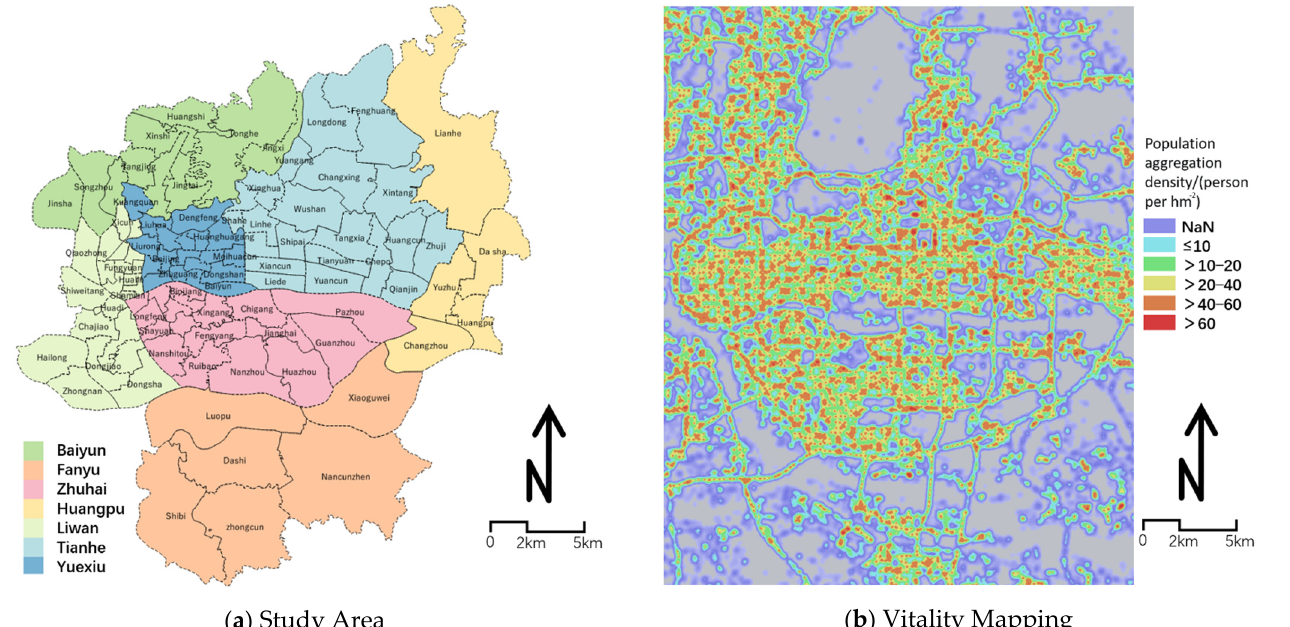
Figure 2. Study area ( a ) central urban area of Guangzhou and ( b ) its vitality in terms of mobile phone hotspot locations. hotspot